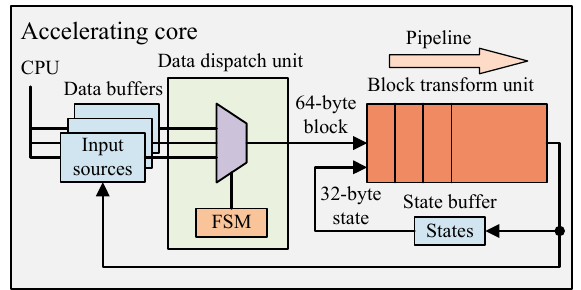
Figure 7: Architecture of the proposed accelerating core.